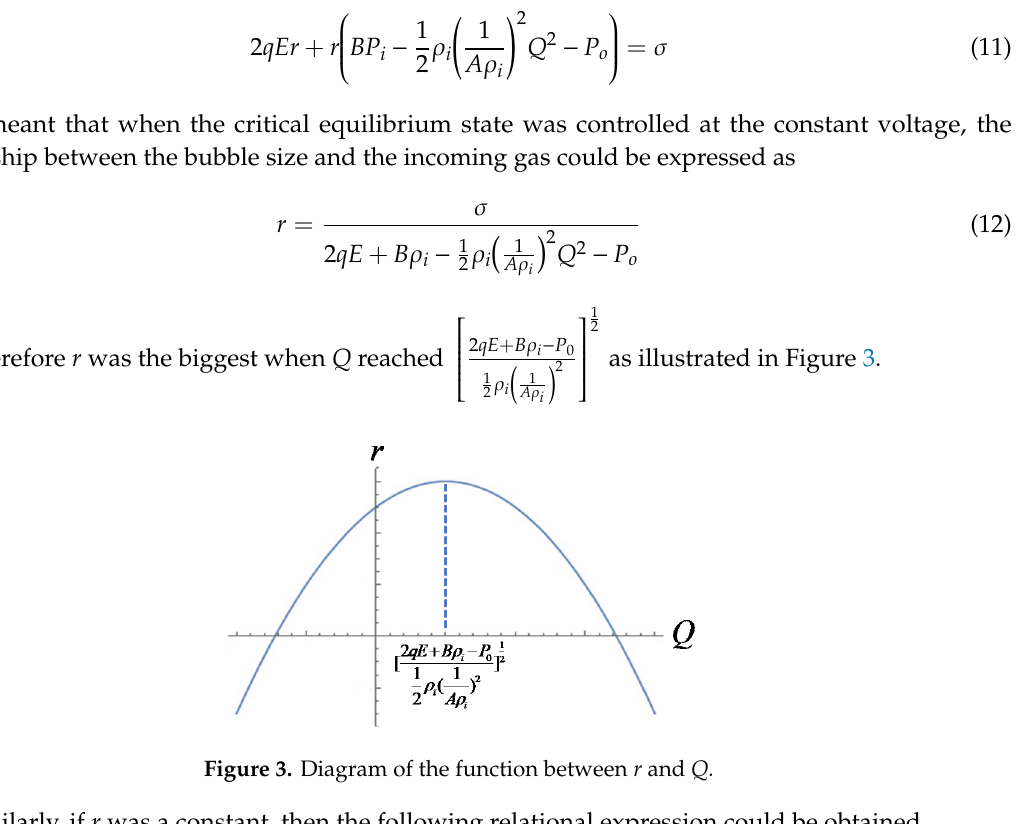
Figure 2. The force analysis model of the bubble during critical bubble electrospinning.